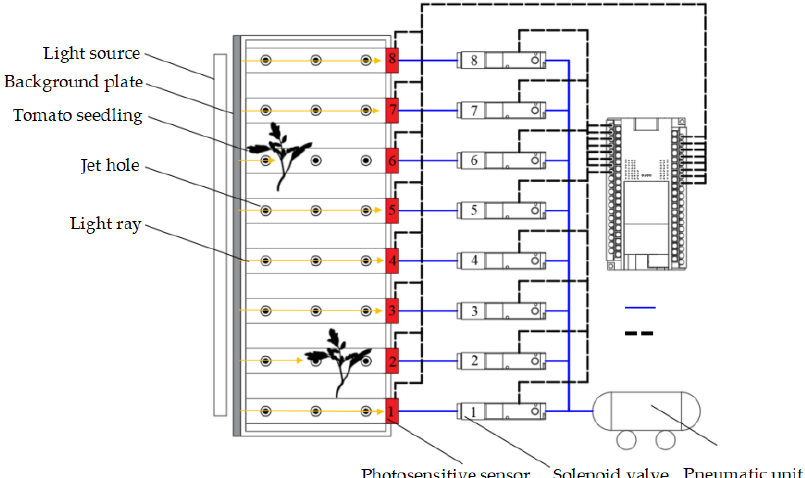
Figure 4. Working principle of the detection module. For the convenience of identification, we rank the photosensitive sensors as No. 1–No. 8. Similarly, we rank the solenoid valves as No. 1–No. 8.